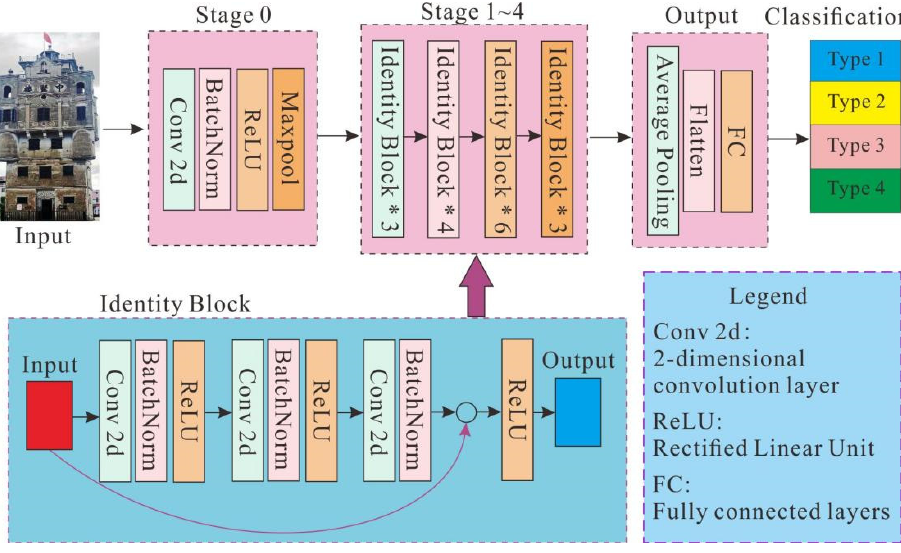
Figure 7. The structure chart of Resnet50.